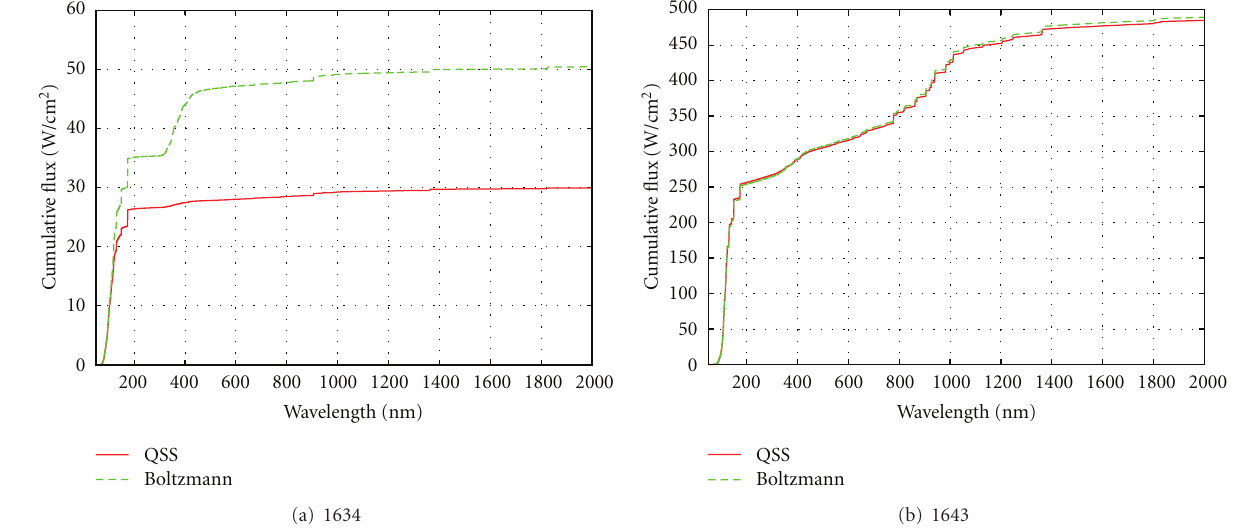
Figure 7: QSS versus Boltzmann.